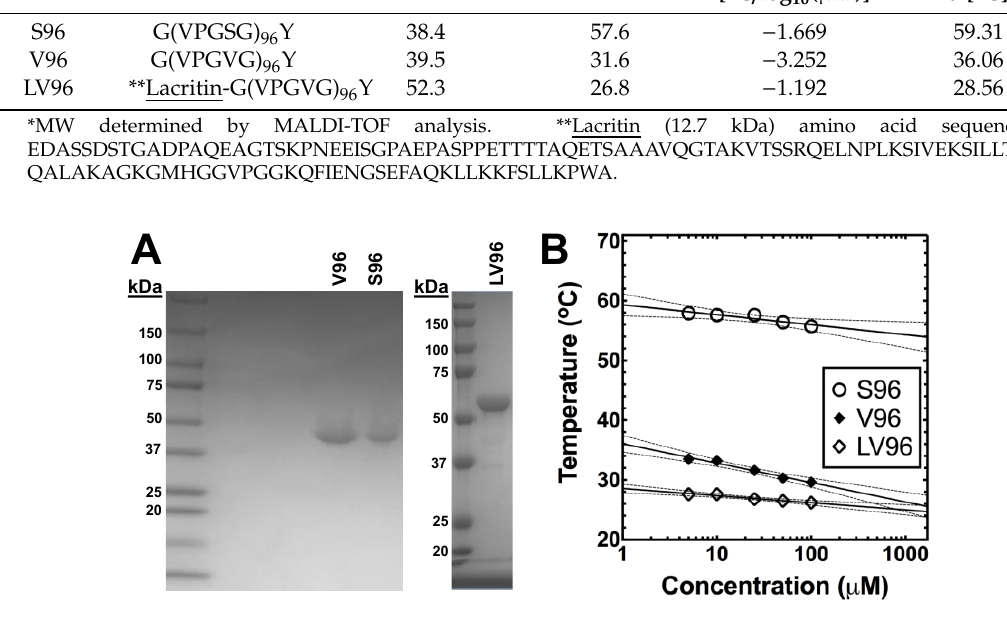
Figure 1. The purity, size, and temperature-dependent phase behavior of V96, S96, and LV96 evaluated for this study. ( A ) Identity and purity of V96, S96 and LV96 were analyzed by SDS-PAGE using Coomassie blue staining. ( B ) The phase transition temperature was plotted vs. concentration as a phase diagram, below which ELPs remains soluble, and fit with Equation 1. Solid line: Fit; Dashed line: 95% confidence interval of mean.